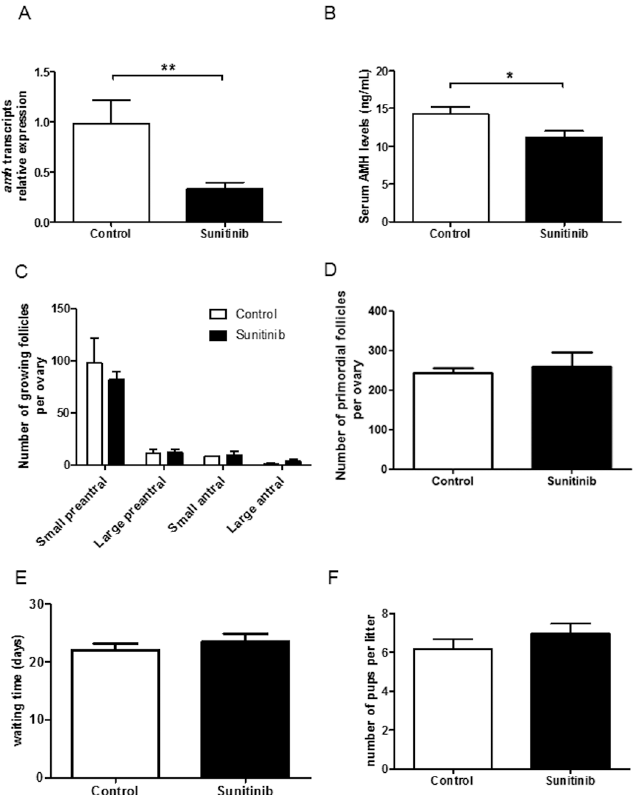
Fig 4. Ovarian reserve evaluation after sunitinib or vehicle treatment. A. Expression of ovarian Amh transcripts normalized to 18S RNA in mice treated by sunitinib (n = 15) compared with control mice (n = 12) ** p < 0.01. B. Serum AMH levels in sunitinib-treated mice (n = 15) compared with control mice (n = 12). * p < 0.05. C. Growing follicle counting in sunitinib-treated mice compared with control mice. D. Primordial follicle counting in sunitinib-treated mice compared with control mice. E. Mean delay to obtain first litter in sunitinib (n = 9) and control (n = 6) mice. F. Mean number of pups per litter obtained during 3 months of observation of sunitinib (n = 9) and control (n = 6)